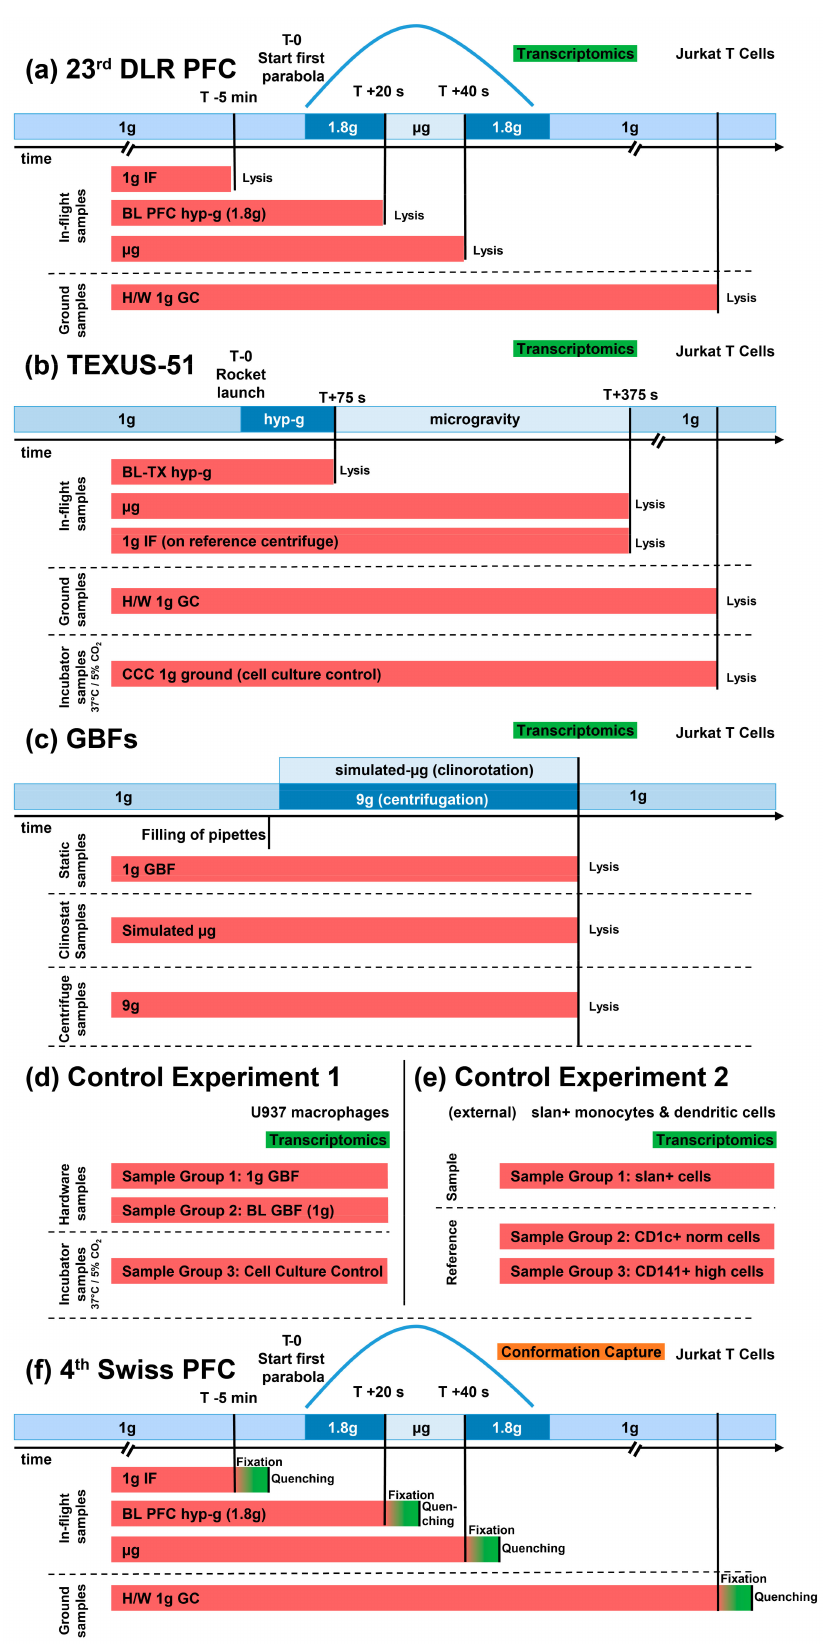
Figure 1. Experiment fixation scheme: overview over experimental conditions from which samples were acquired. Transcriptomics datasets are indicated in green, and high-throughput chromatin